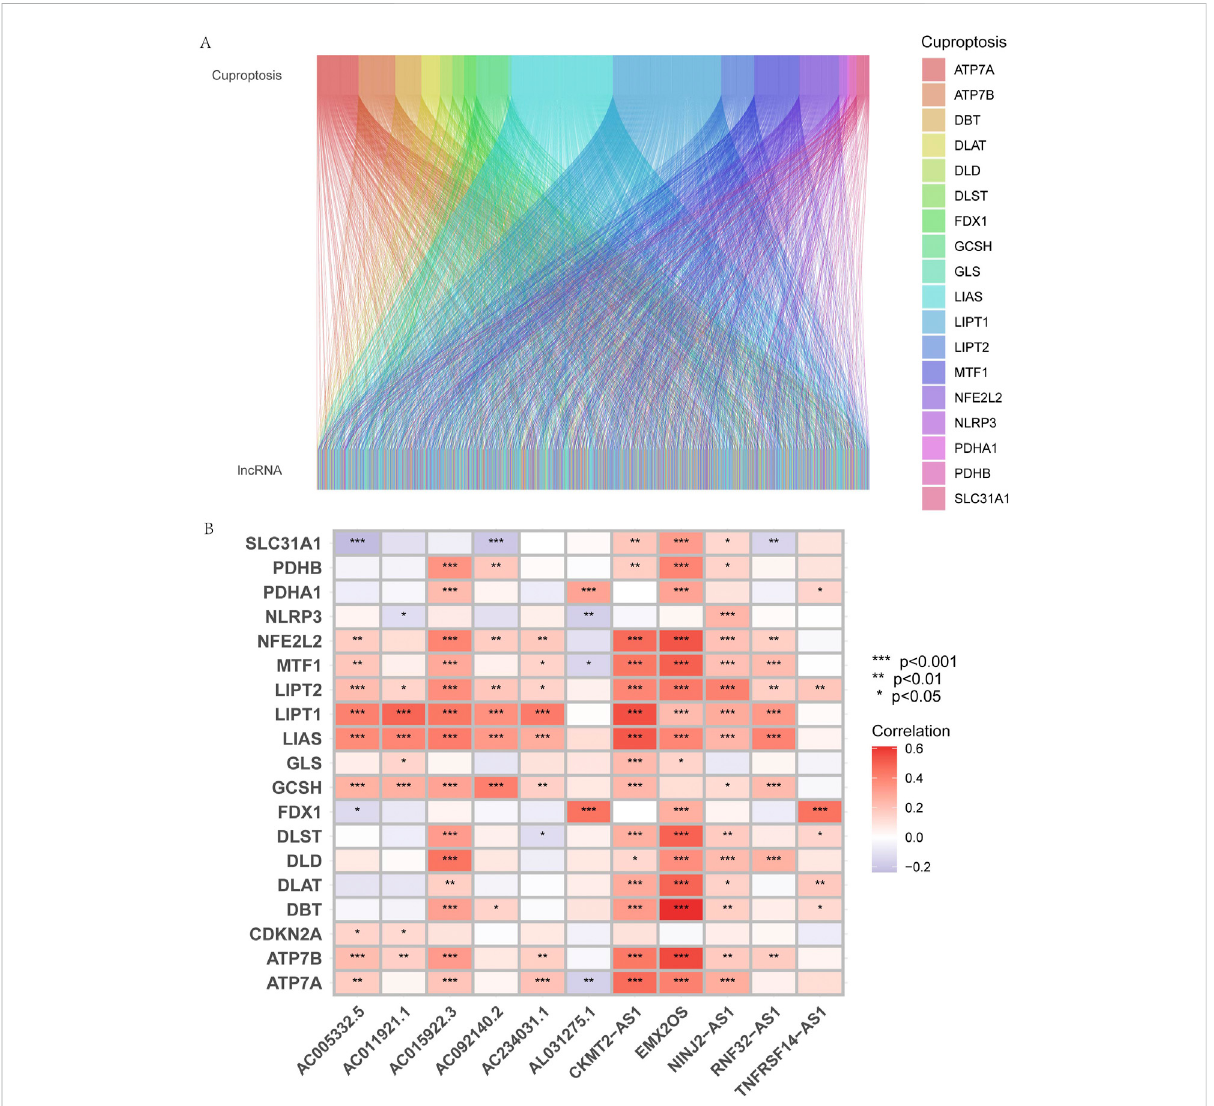
FIGURE 1 Identi fi cationofcuproptosis-related lncRNAs andconstruction ofprognosis signatures. (A) Sankey diagramshowed theresultsofcuproptosis- related genes and cuproptosis-related lncRNAs co-expression. (B) The correlation heatmap showed the relationship between cuproptosis-related lncRNA signatures and cuproptosis-related genes. Red represents positive correlations, and blue represents negative